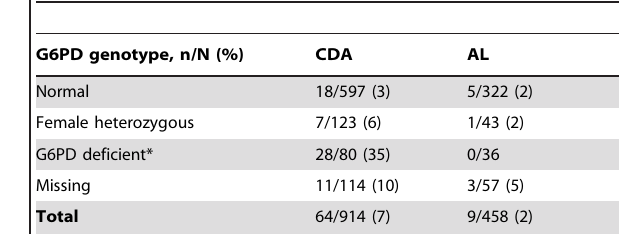
Table 6. Occurrences of the hemoglobin safety composite endpoint (hemoglobin decrease of $ 40 g/L or $ 40% versus baseline or hemoglobin , 50 g/L or blood transfusion) by G6PD genotype in the ITT (safety)